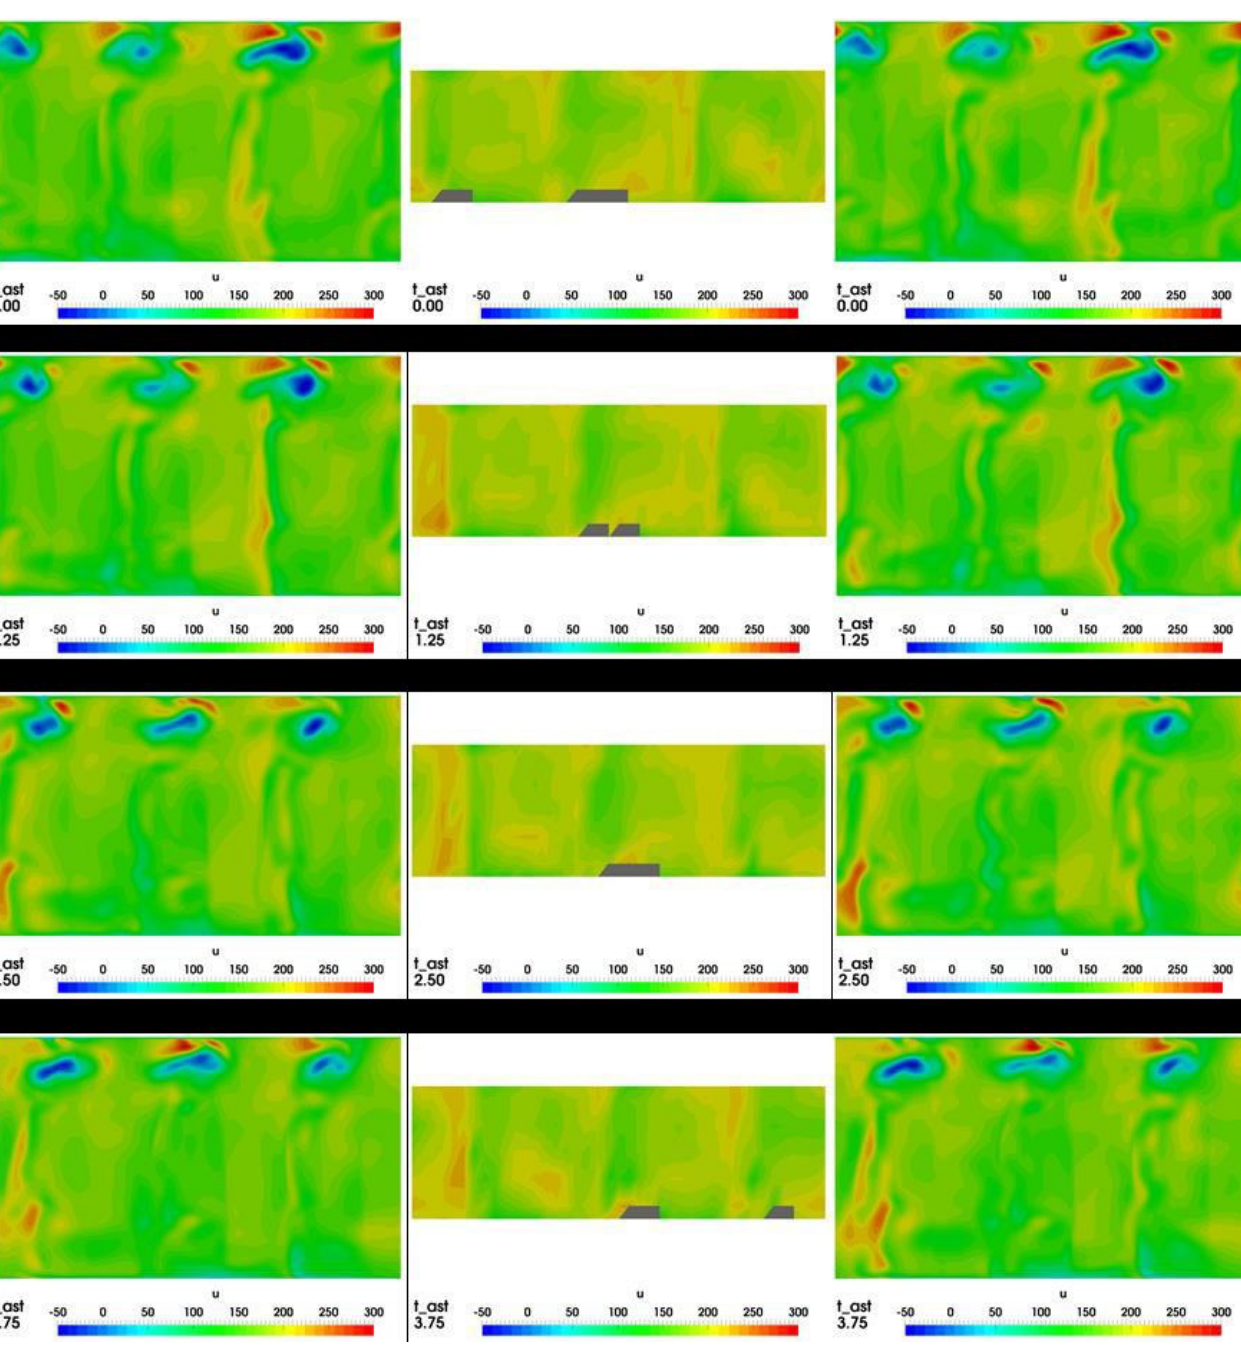
Figure 10. Instantaneous measured ( mid ) and computed ( left : 18%/5 mm inlet turbulence, right : 12%, 1 mm inlet turbulence) velocity in plane C1 after the rotor (view in upstream direction).